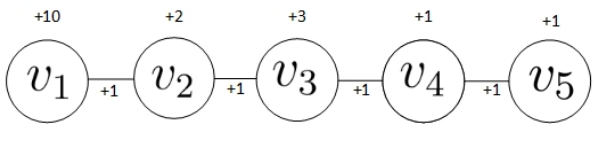
Fig. 3. A path with 5